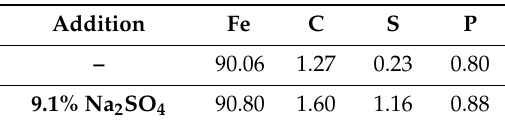
Table 6. Chemical composition (wt.%) of the concentrates obtained by roasting of the red mud B at 1250 ◦ C and 180 min duration time without additions and with addition of 9.1% Na 2 SO 4 and following magnetic separation.